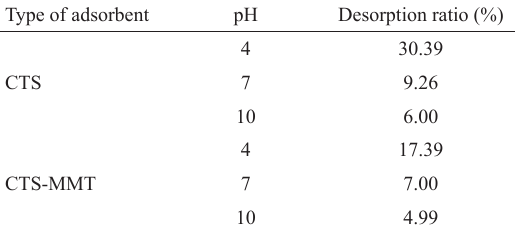
Table 4: Desorption of Ag + from CTS and CTS-3%MMT composite bead. Type of adsorbent